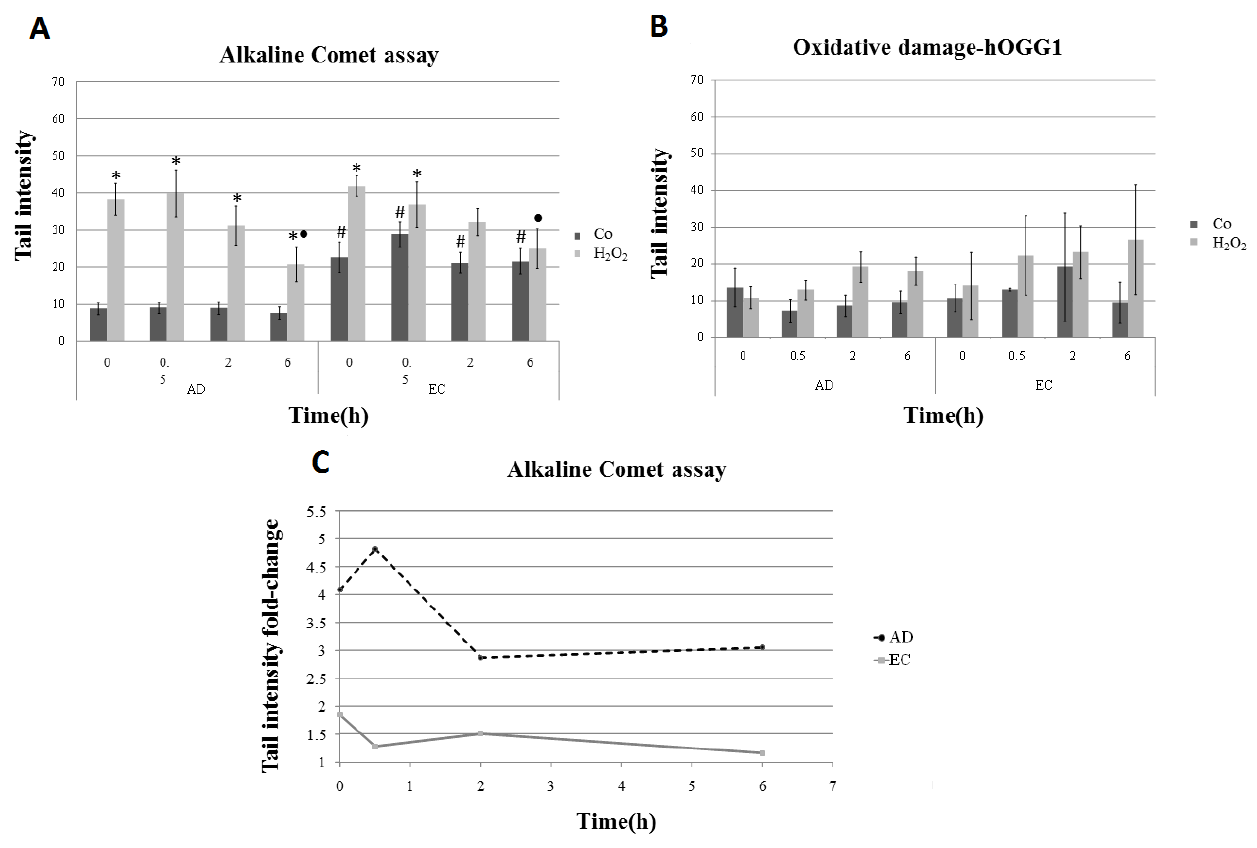
Figure 1. DNA damage measured as tail intensity (% of DNA in the tail) in the comet assay. Lymphocyte cultures from AD and EC groups of individuals were submitted to treatment with hydrogen peroxide (H O ) for 1 h and harvested at different recovery times 2 2 (0, 0.5, 2 and 6 h) after treatment. ( A ) DNA damage analyzed by alkaline comet assay; ( B ) estimated net amount of oxidative damage: each value of tail intensity obtained in the conventional comet assay (without hOGG1 enzyme) was subtracted from that observed in the assay performed with the addition of hOGG1; ( C ) scatterplot showing the extent of DNA damage presented by treated samples in relation to the control samples; fold-change was calculated using mean values of tail intensity. * Statistically significant difference between each treatment with H O , and its respective control ( p < 0.05); ● Statistically 2 2 significant difference between the mean values of tail intensity obtained at 0.5, 2 and 6 h of recovery relative to the corresponding initial time (0 h) ( p < 0.05); # Statistically significant difference when the EC sample was compared with the corresponding AD sample ( p <